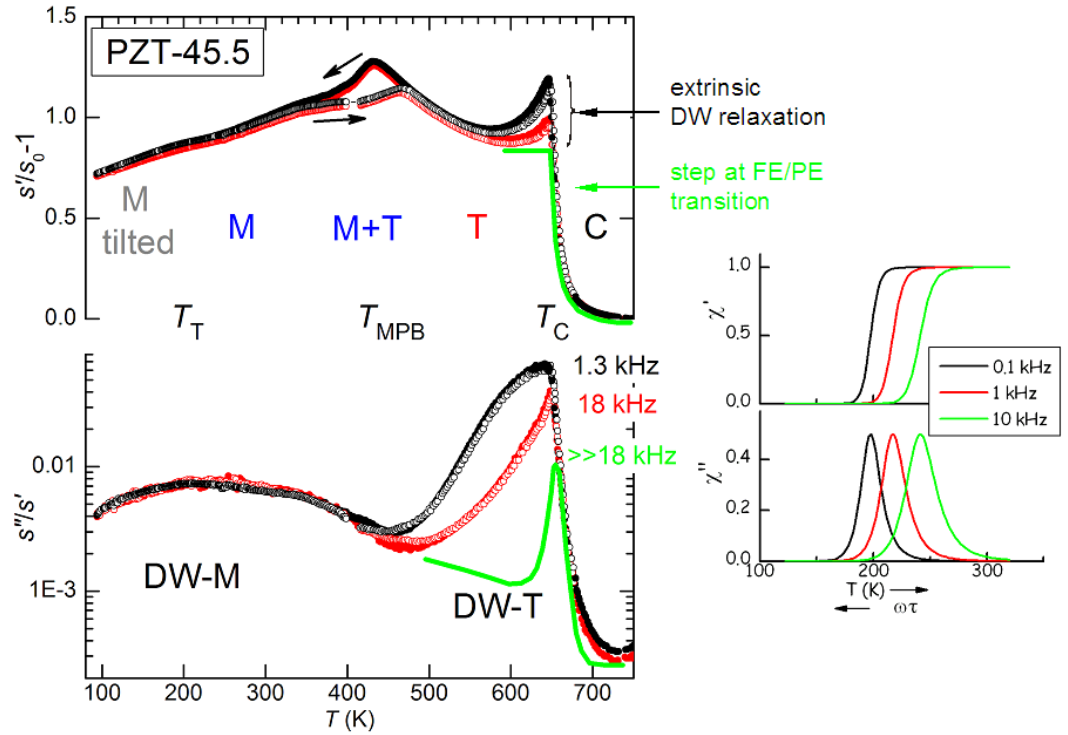
Figure 11. Real part of the compliance s = 1/ Y and elastic energy loss coefficient of PZT-45.5 measured at 1.3 and 18 kHz (data from Ref. [77]). The hypothetical green curves are for a much higher frequency, where the tail of the thermally activated DW relaxation is shifted at T > T C . On the right is a sketch of a relaxational contribution with its frequency